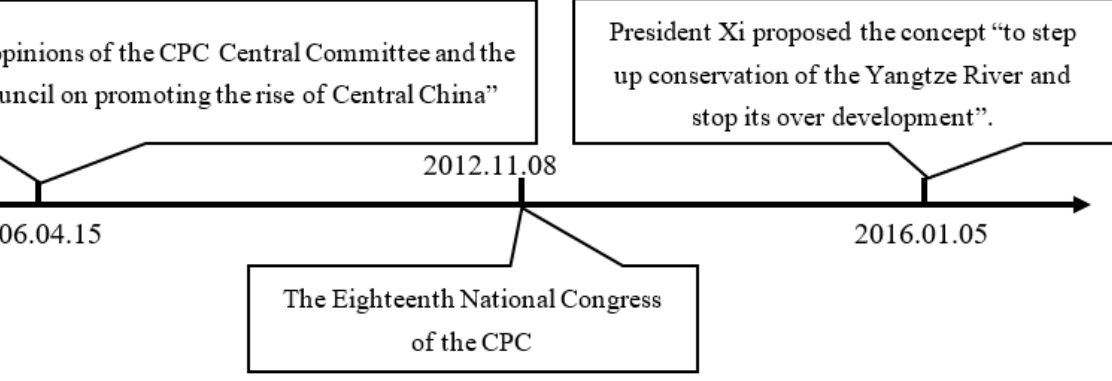
Figure 1. Important events affecting the policy environment in Central China. Note: Built by the authors.